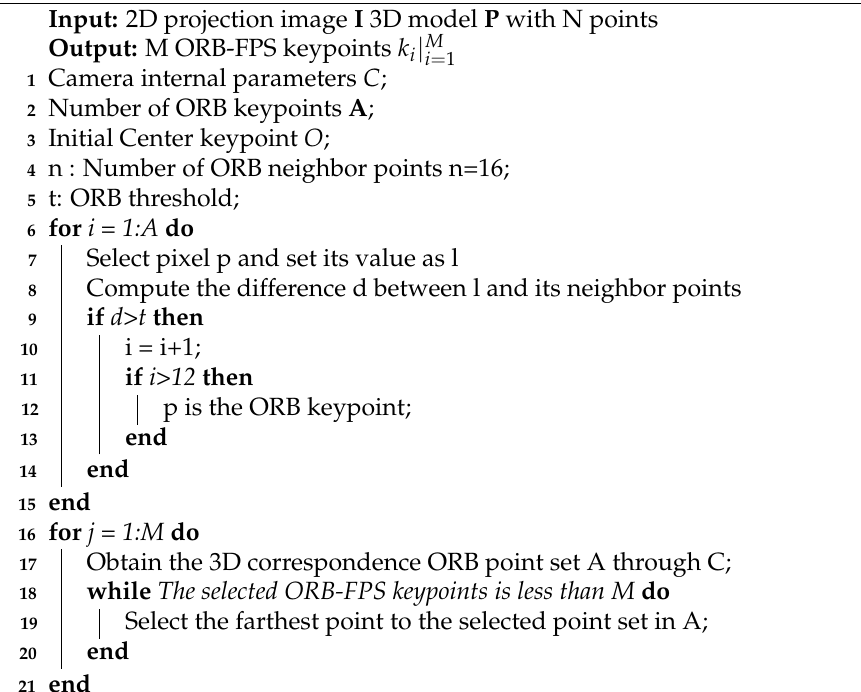
Algorithm 1: ORB-FPS keypoint